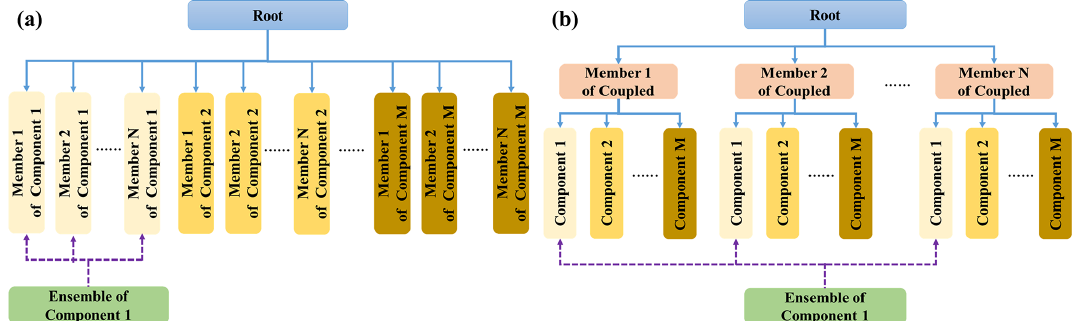
Figure 5. Two examples of the organization of N ensemble members of a coupled model consisting of M component models. (a) Single-level organizational architecture of all ensemble members of the component models in the coupled model. (b) Two hierarchical level organizational architecture. All ensemble members of the coupled model are organized as the first level with all component models from each ensemble member of the coupled model at the second level. An ensemble-set component model that covers all ensemble members of component model 1 is generated as an example for using the DA algorithm in ensemble component